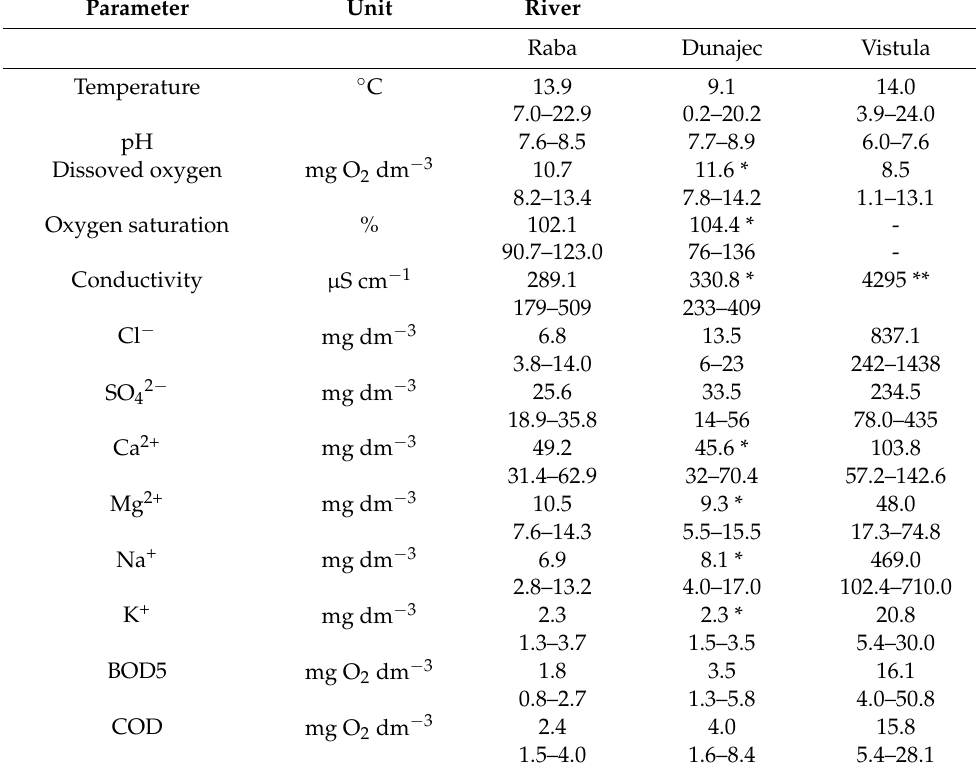
Table 2. Mean and range values of physico-chemical parameters in the waters of Raba (1966–1967) [19], Dunajec (1990 and 2000 *, data from Provincial Inspectorate for Environmental Protection in Krak ó w), and Vistula (1982–1983) [24,25]